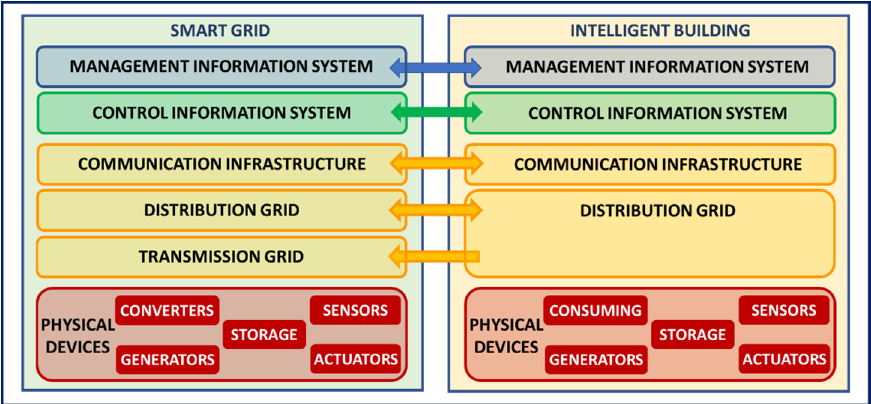
Figure 2. Global perspective of the integration of IBs and SG as SoS.